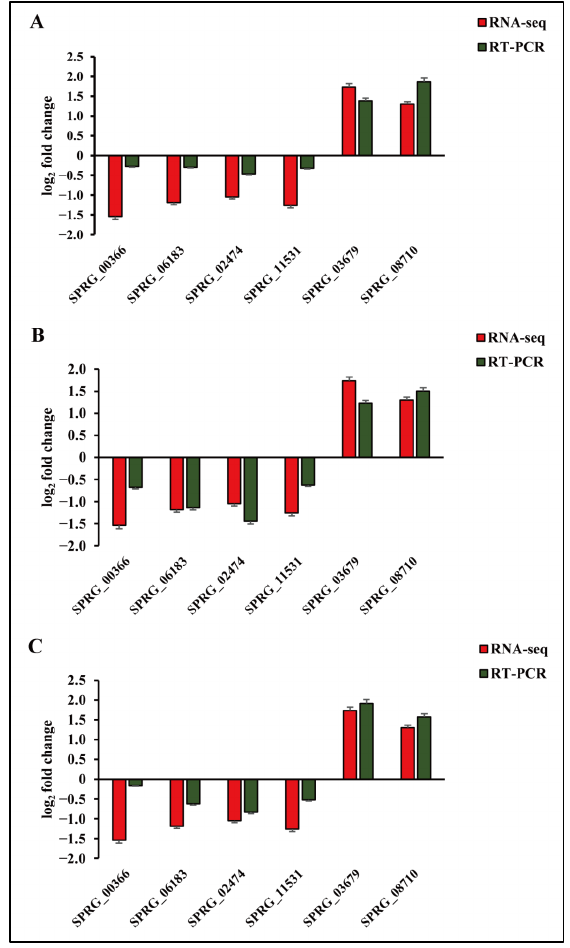
Figure 7. Comparison of RNA-seq results and qRT -PCR analysis of gene expression levels. ( A ) Log 2 fold change of 6 genes for control vs. metalaxyl ( A ), control vs. bronopol ( B ), and control vs. copper sulfate groups ( C ).